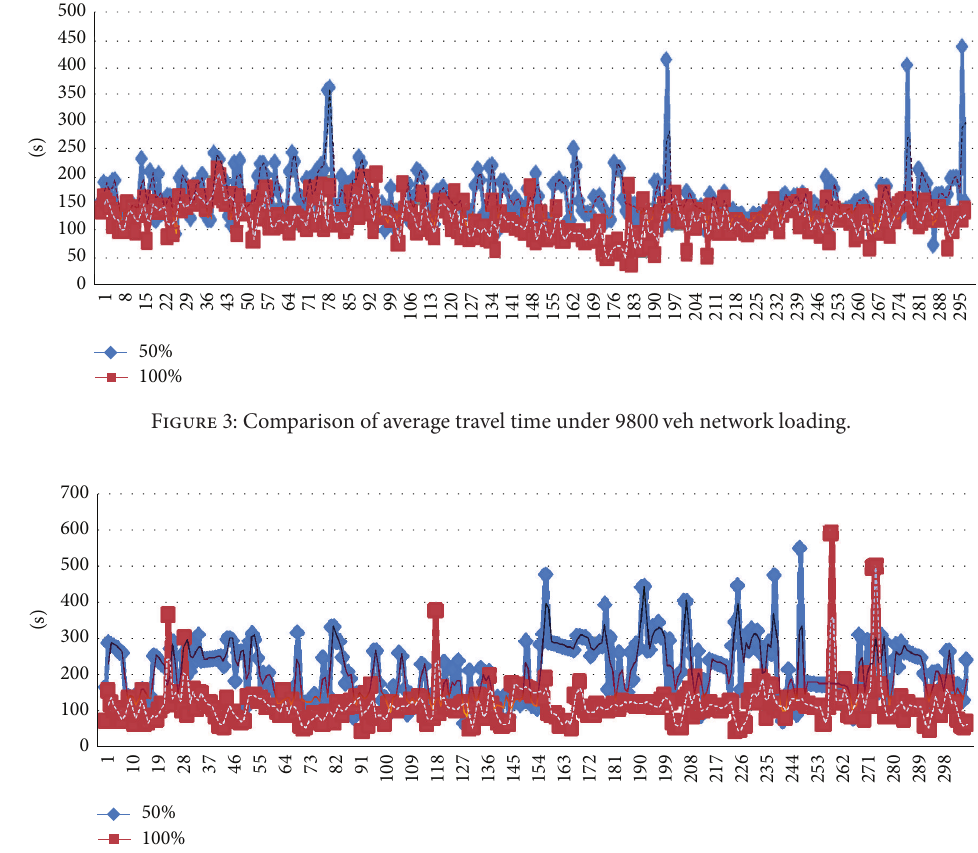
Figure 4: Comparison of average travel time under 12200 veh network